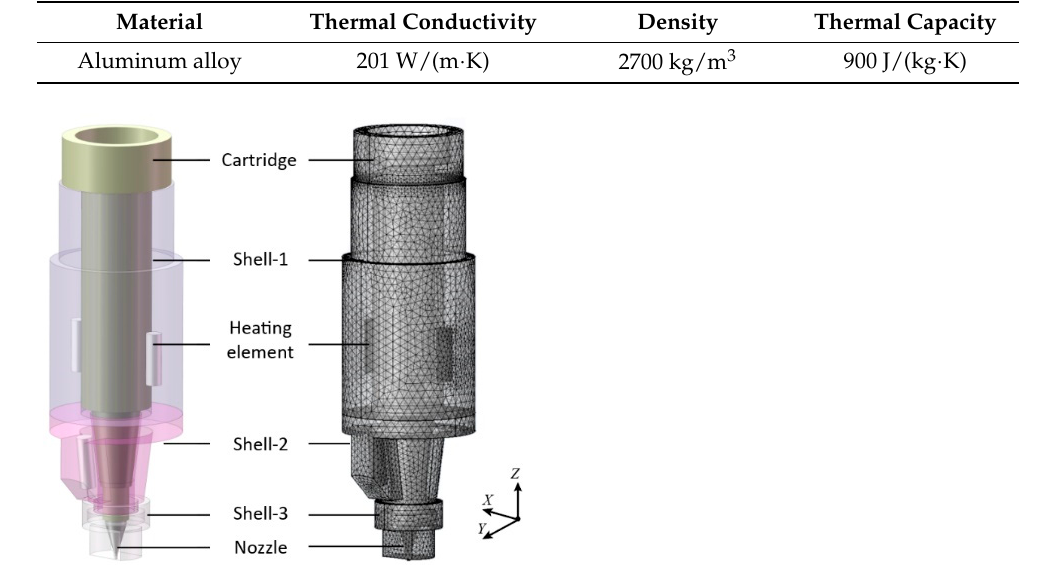
Figure 2. Simplified model and computational mesh of the print head. Table 1. Parameters selected for the simulation.